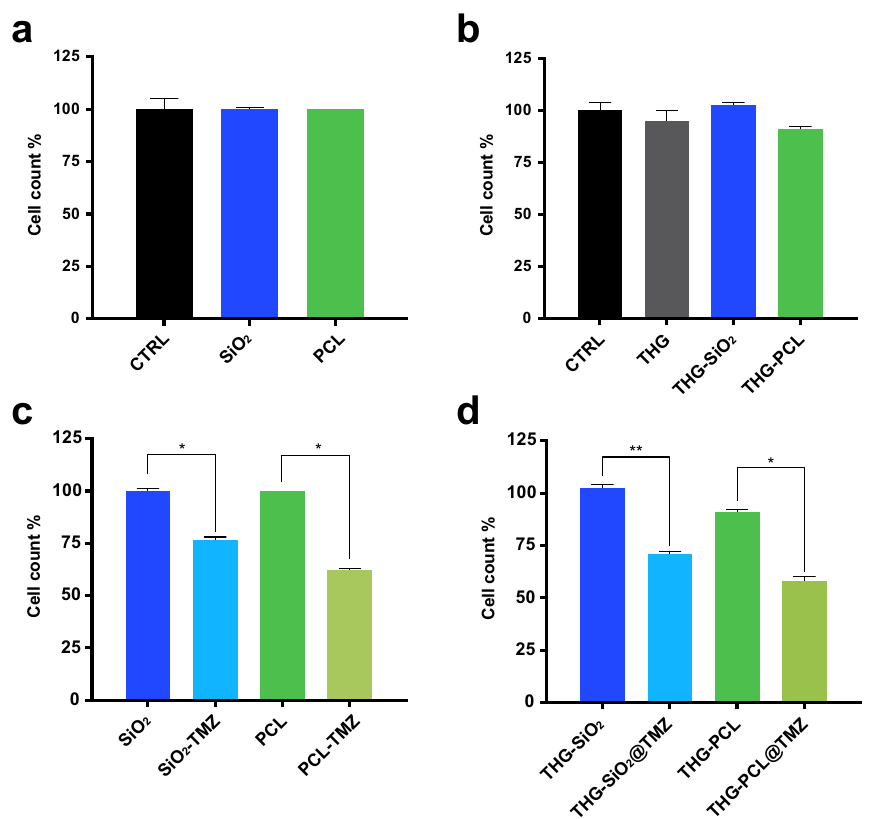
Figure 3. In vitro effect of the isolated components and of assembled new gel formulations on Glioblastoma cells. ( a ) U87-MG-Red-FLuc cells were treated with cell medium (CTRL), mesoporous SiO 2 nanoparticles (SiO 2 ) and polycaprolactone microparticles (PCL) for 24 h, causing no significant reduction in viable cells number. ( b ) U87 MG-Red-FLuc cells were treated with cell medium (CTRL), the empty thermogel (THG), and the thermogels containing mesoporous SiO 2 nanoparticles (THG@SiO 2 ) and polycaprolactone microparticles (THG@PCL) for 24 h, causing no significant reduction in viable cells number. ( c ) TMZ-containing SiO